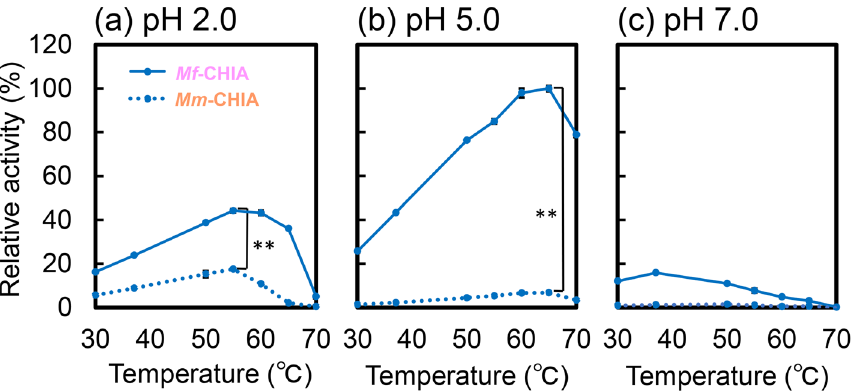
Figure 3. The optimal temperature of Mf -CHIA and comparison with Mm -CHIA. The chitinase activity was investigated between 30 and 80 °C for 60 min in McIlvaine’s buffer. ( a ) pH 2.0, ( b ) pH 5.0 and ( c ) pH 7.0. Solid lines, Mf -CHIA; dotted lines, Mm -CHIA. We show relative activities of both enzymes where the peak activity of Mf -CHIA under optimal conditions (pH 5.0 and 65 °C) was set to 100%. The chitinolytic activities are expressed with the subtraction of the blank experiments. Error bars represent mean ± standard deviation from a single experiment conducted in triplicate. ** p < 0.01.